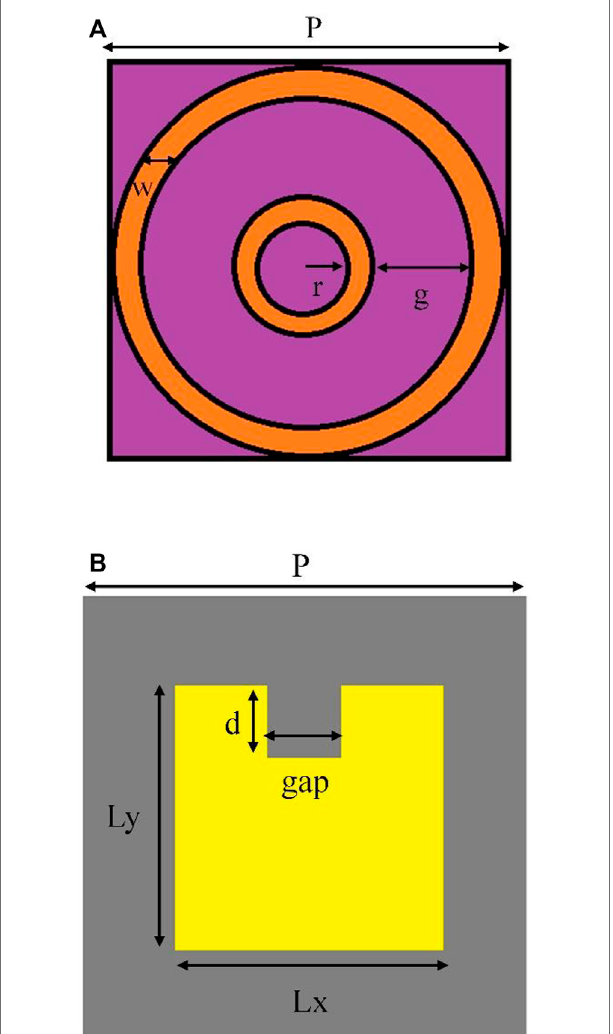
FIGURE 6 | Metamaterial perfect absorbers (A) ring and (B) patch.